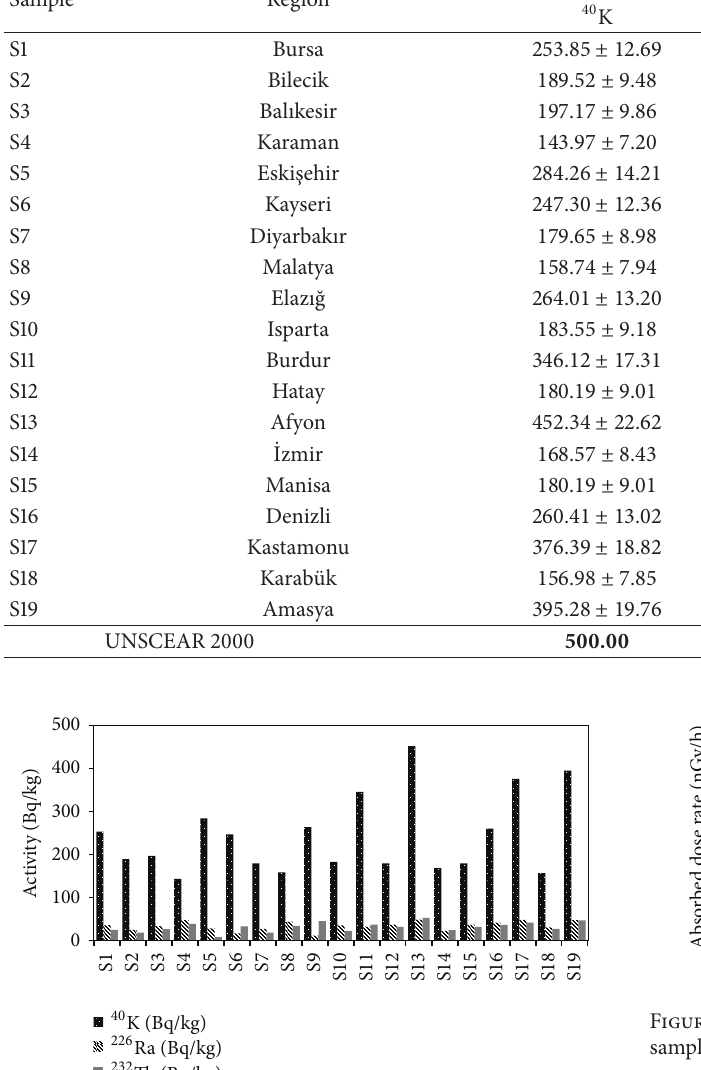
Table 1: The activity concentration of 40 K, 226 Ra, and 232 Th (in Bq/kg) of sedimentary rock samples. Sample